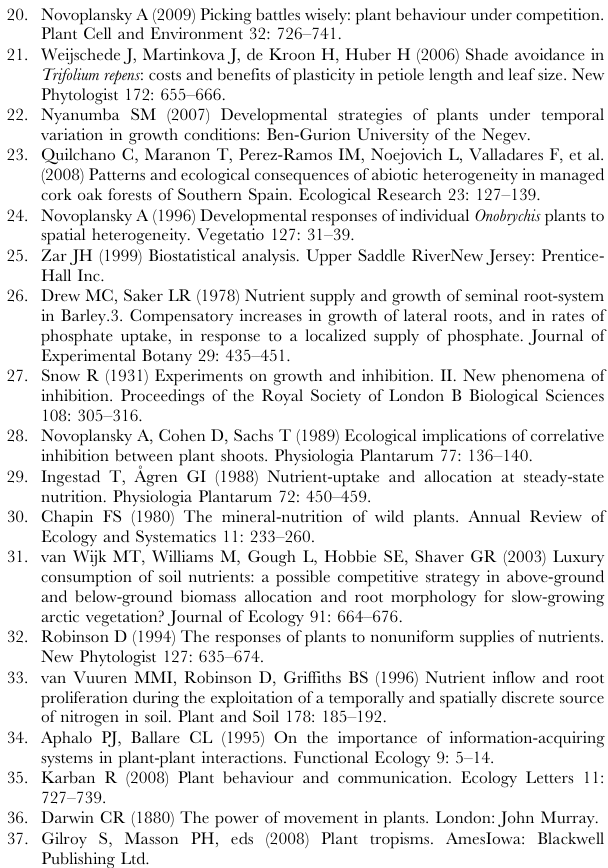
Text S1 Technical information not mentioned in the Materials and Methods. Table S1 Correlations between root length, volume, and biomass. Table S2 One-way ANOVAs for the effects of treatment on plant performance at the interim and final harvests.